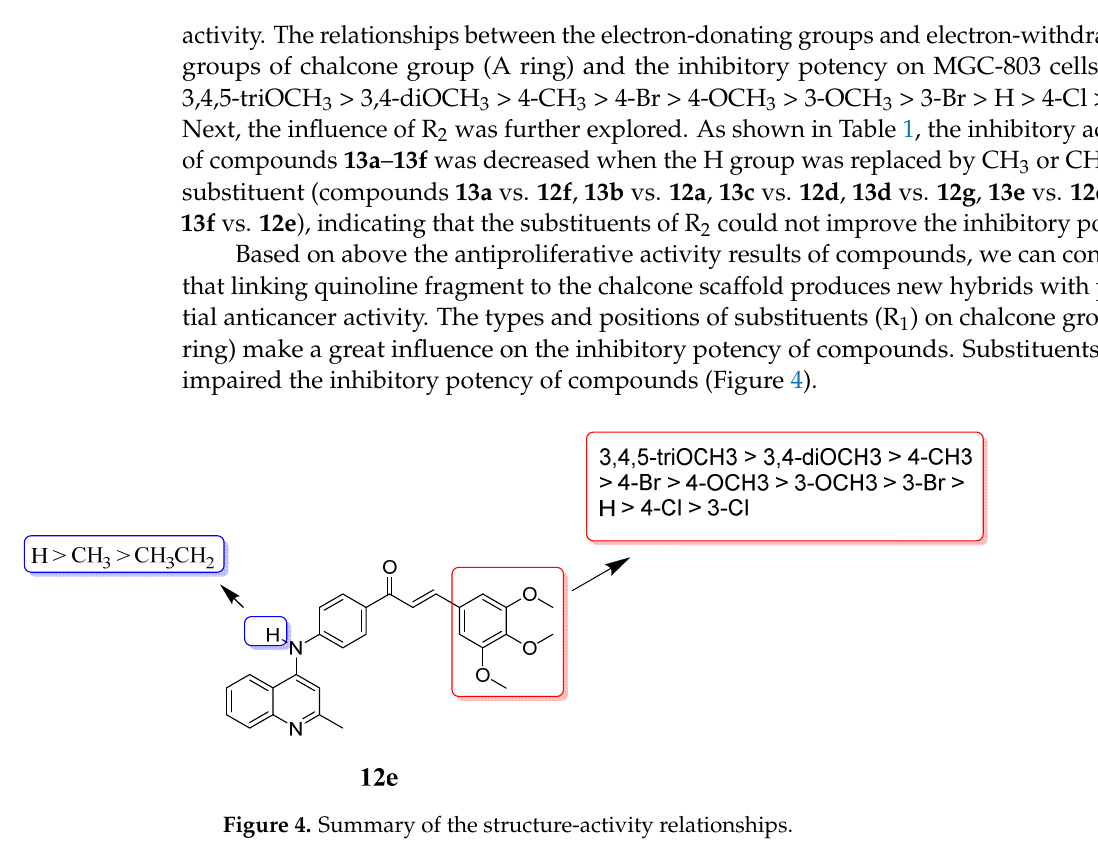
Figure 4. Summary of the structure-activity relationships.